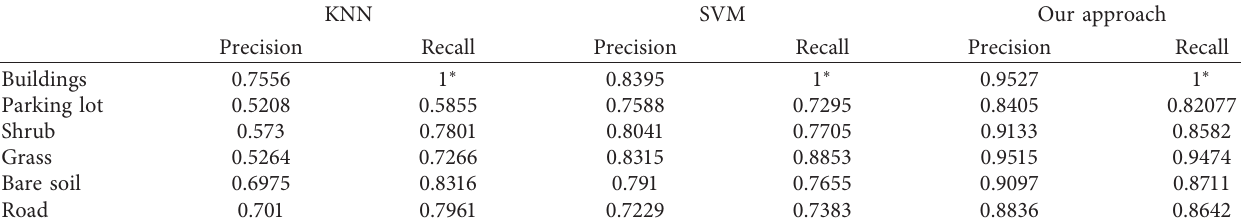
Table 6: Quantitative evaluation of recognition results based on the first experimental datasets. KNN